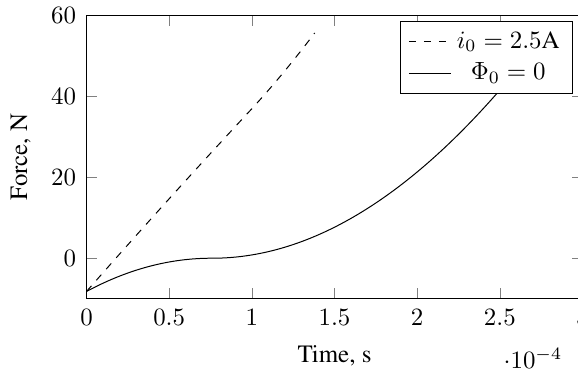
Figure 3. Comparison of the force growth for the biased AMB with i zero-bias case when the rotor remains in the central